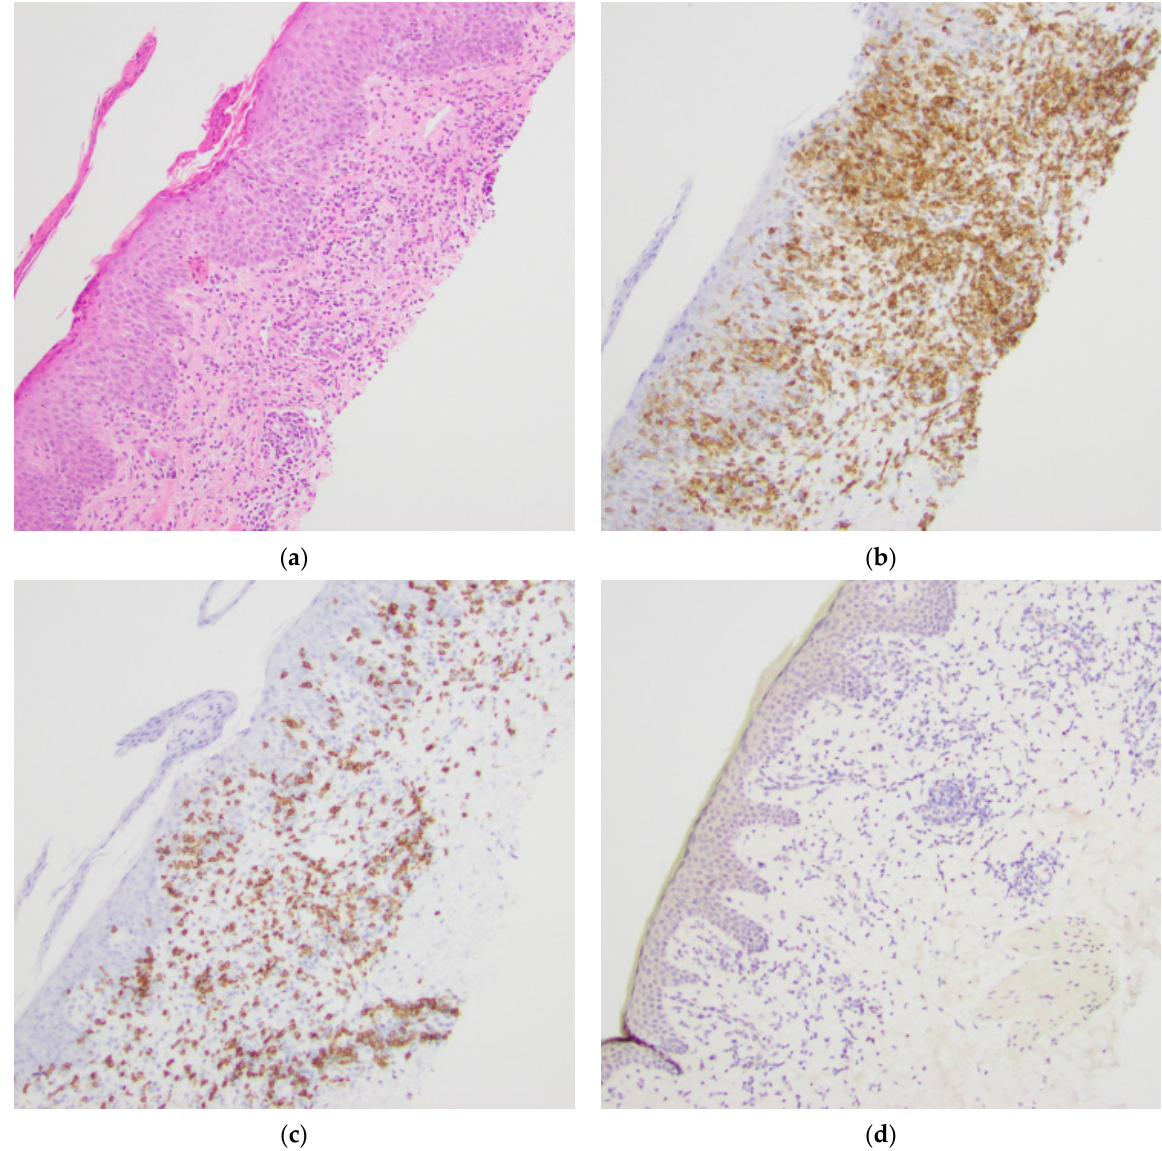
Figure 5. Sample case with a predominant CD4+ epidermotropic T-cell infiltrate with melanocyte loss shown by complete focal loss of SOX10 IHC staining. The patient was an 86-year-old male with a long history of hyperpigmented rash in sun-protected areas. ( a ) Hematoxylin and eosin-stained section, original magnification 100×. ( b ) T-cells highlighted by a CD4 IHC stain, original magnification 100×. ( c ) T-cells highlighted by a CD8 IHC stain, original magnification 100×. ( d ) Negative SOX10 IHC staining, original magnification 100×.